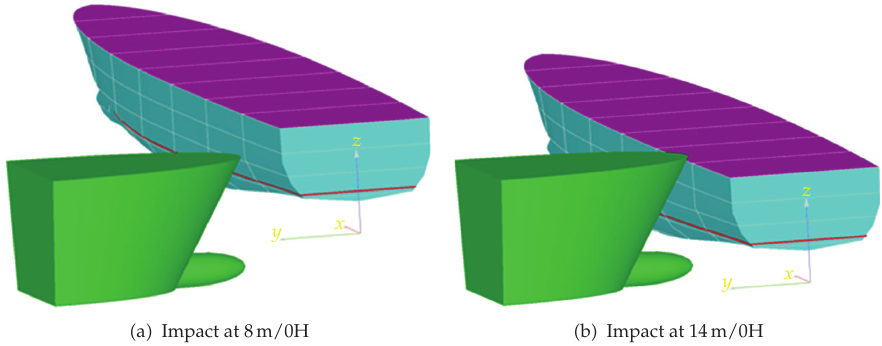
Figure 17: Vertical impact sensitivity analysis: varying draught of striking vessel.